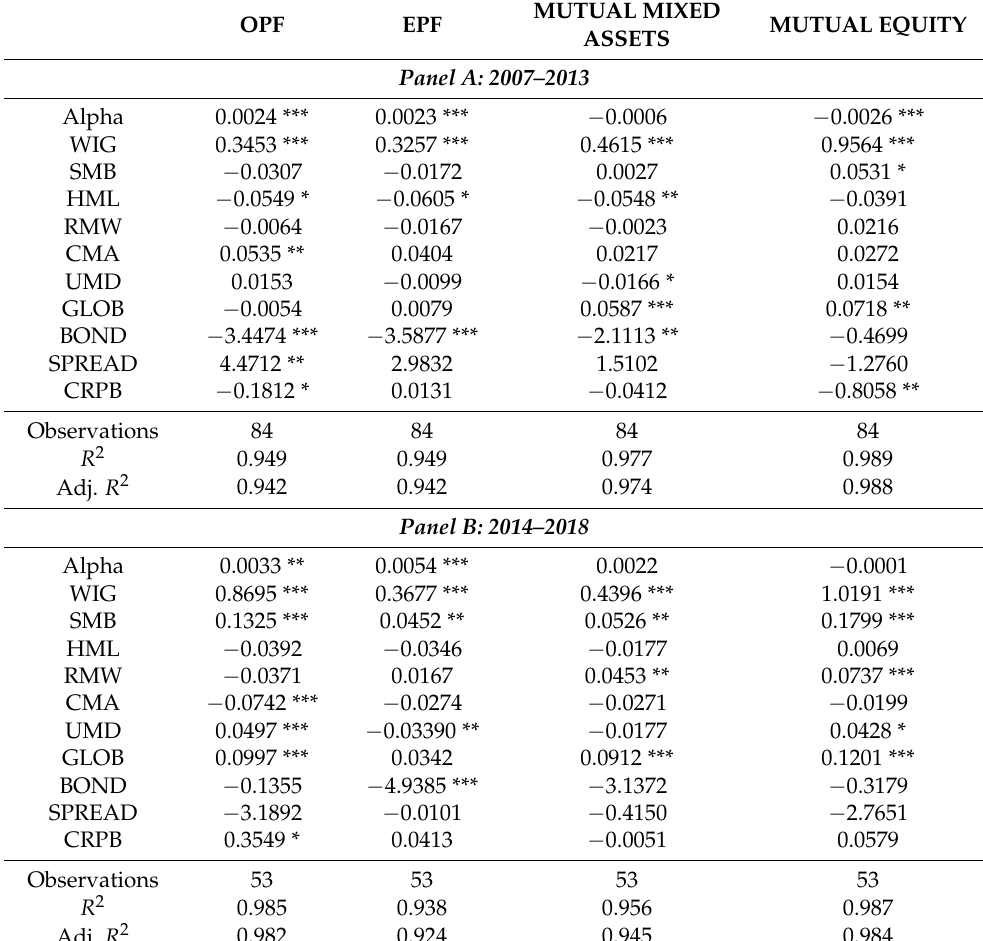
Table 2. Performance of equal-weighted portfolios of pension funds and mutual funds in the Polish pension